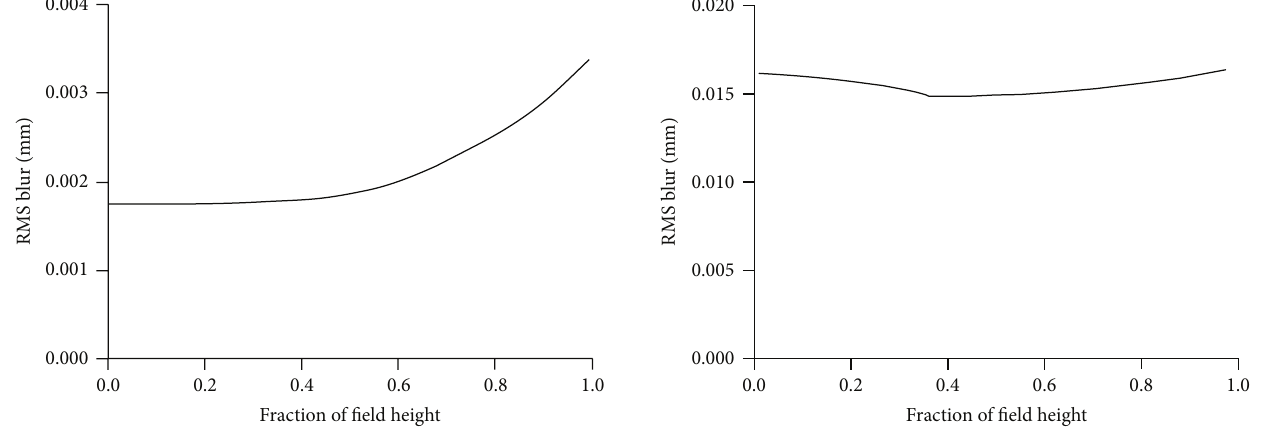
Figure 4: RMS spot diameter versus field height in mm for projec- tor.